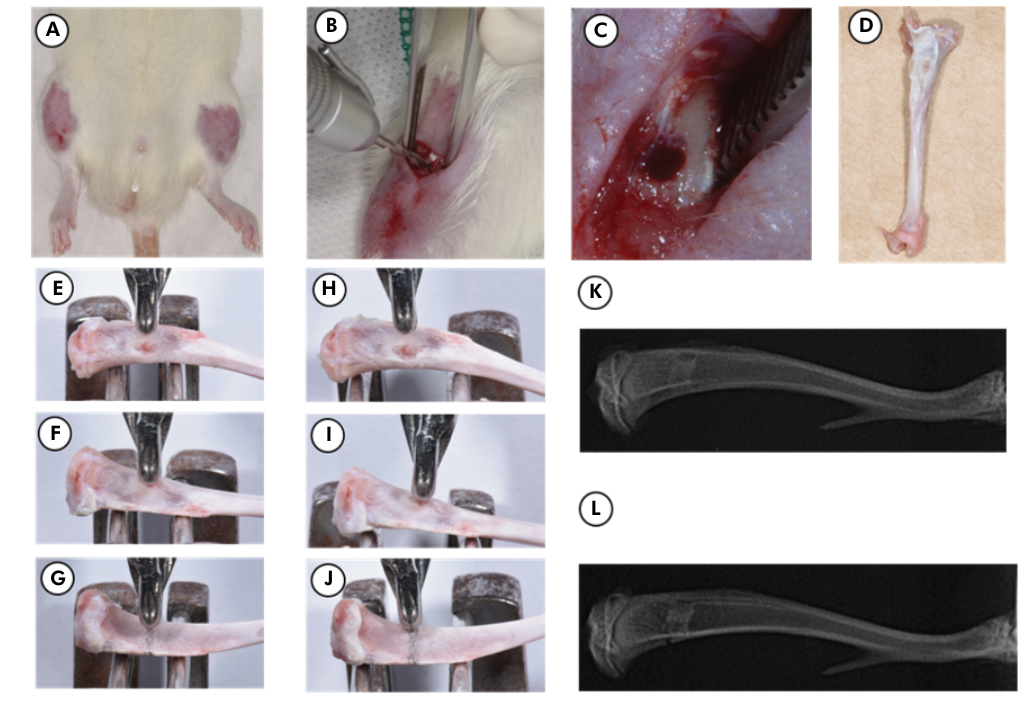
Figure 1. Surgical procedure and positioning of the tibia during three-point bending test on the rat tibia. Radiographics shows the tibia before and after the test. A.Trichotomy on the tibia; B. Creation of the bone defect in standardized location on the tibia methaphisis; C. Bone defect of 1.6 mm diameter; D. Removal of the tibia by disarticulation; Positioning of the load pplication in relation to the bone defect: E. frontal; F. upward; G. and downward with 6 mm of distance between the supports; H. frontal; I. upward; J. and downward with 10 mm of distance between the supports; K. Radiographic image of the tibia before three-point bending test; L. Radiographic image of the tibia after three-point bending test showing crack propagation in the bone defect